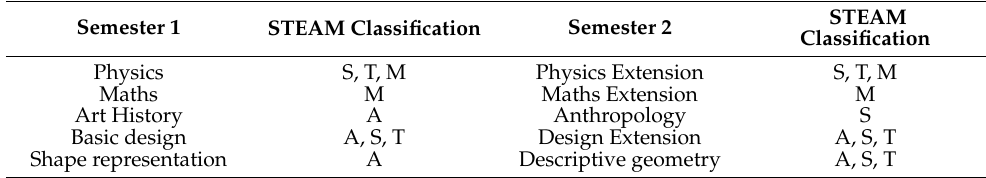
Table 1. First-year subjects of bachelor of engineering in design and their classification into STEAM categories (Science, Technology, Engineering, Art, Math).